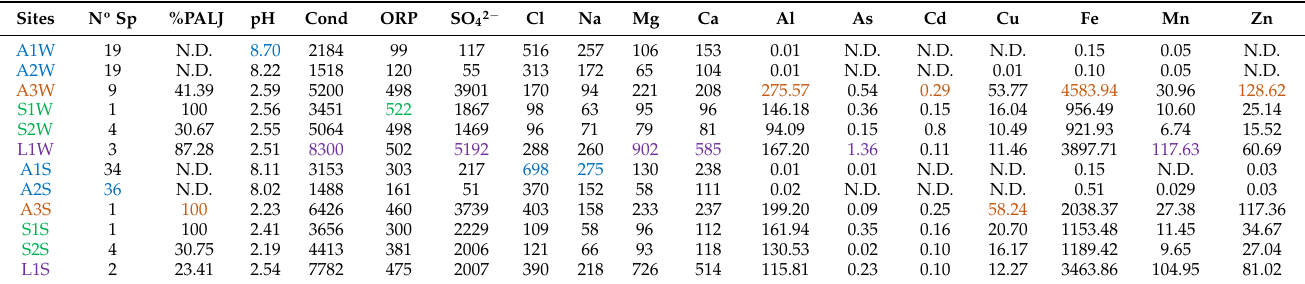
Table 1. Biological and physicochemical parameters (concentrations in mg/L) from the selected points in 2016. Conductivity measured in µ S/cm and ORP in mV; color code for highest concentrations of the parameters in the sampling sites: A1, A2 blue; S1, S2 green; A3 orange; L1—purple; the letter at the end of sample name indicates the sampling period, thus W—winter and S—summer; (N.D.—not detectable).